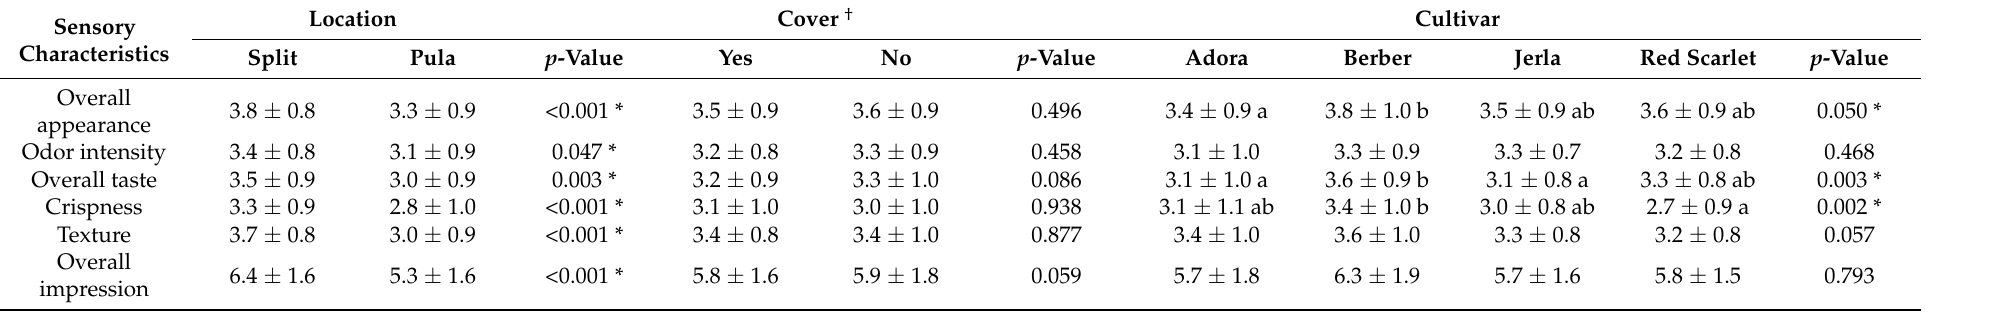
Table 5. Sensory characteristics of potato tubers affected by location, plant cover and cultivar in the first year.